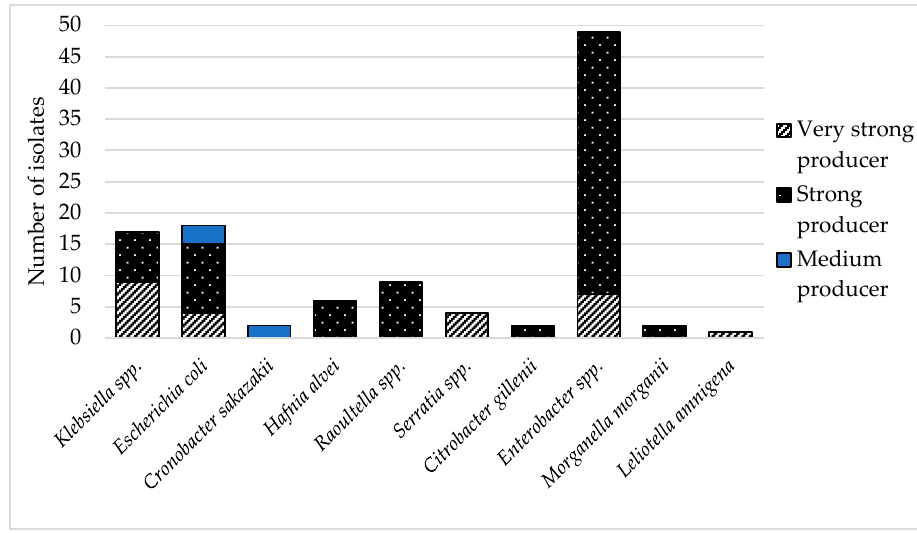
Figure 2. Types of biofilm production of antibiotic-resistant isolates.